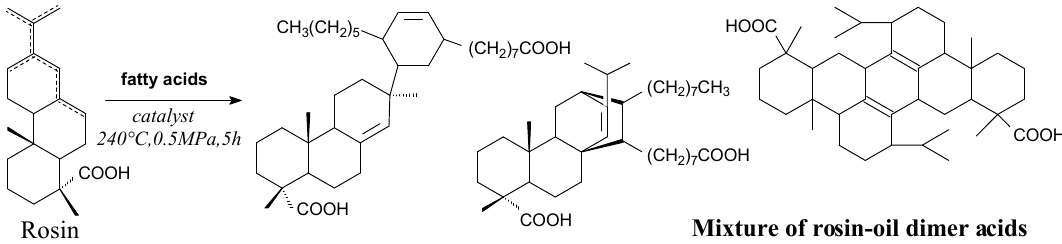
Scheme 48. Preparation of rosin-oil dimer acids mixture.